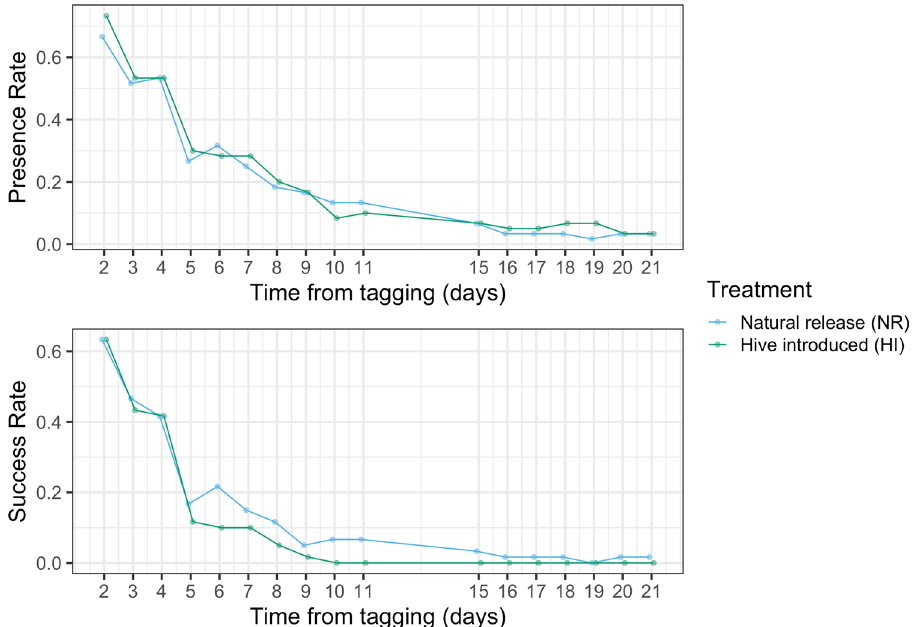
Figure 4. Presence and success of foragers on the days following introduction to the three observation hives. The age of foragers is unknown, as foragers were collected from hive